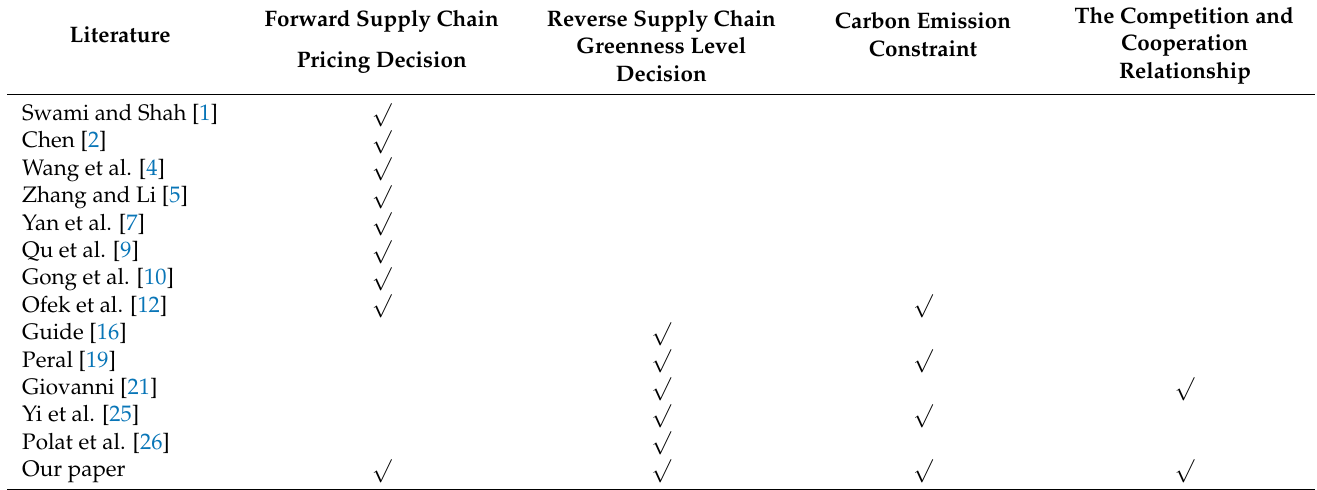
Table 1. The difference between our paper and the previous